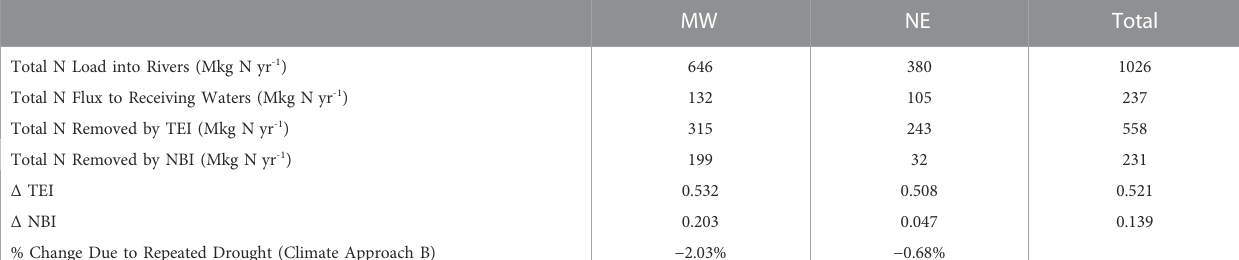
TABLE 5 Key total nitrogen (N) budget statistics for point source pollution for the NE and MW using the SPARROW model. Two single factor experiments, detailed inthenarrative,wereusedtoisolatetheimpactofengineeredwasteprocessing versus naturalinstreamecosystemprocessestolimittotalN fl ux.ValuesfortheNE refertoriversdrainingintooceanreceivingwaters.FortheMWtheyrepresentestimatesmadeatthedownstreamendpointoftheUpperMississippiRiverBasinat the intersection of the Missouri, Arkansas, and Tennessee state boundaries. Results are for mean annual conditions over the period 2010 – 19.